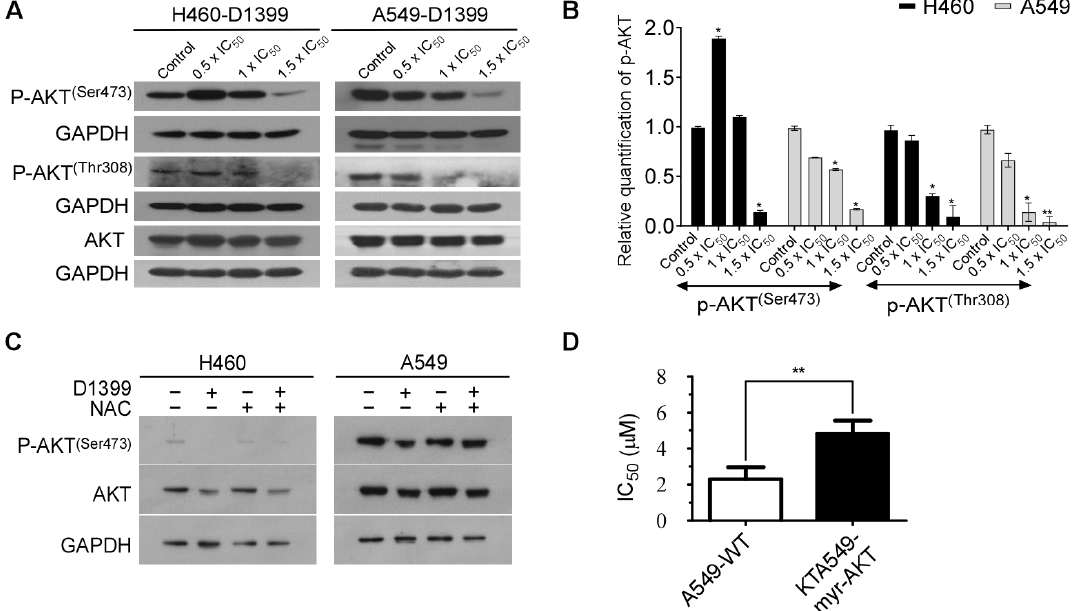
Figure 5. D1399 induces the ROS-dependent inactivation of the AKT signaling pathway in H460 and A549 cells. ( A ) The levels of AKT phosphorylation at Ser473 and Thr308 and total AKT were tested under the treatment of D1399 at indicated concentrations by western blotting in H460 and A549 cells. GAPDH is used as the control; ( B ) Bar graphs illustrating the relative expression levels of p-AKT proteins quantified by western blotting. All protein levels were normalized to the GAPDH protein level; ( C ) The levels of AKT phosphorylation at Ser473 and total AKT were tested by western blotting in H460 and A549 cells. The cells were either treated with D1399 for 6 h or pre-treated with 2 mM NAC for 1 h before D1399 treatment. GAPDH is used as the control; ( D ) The IC 50 of A549-WT and A549-myr-AKT under the treatment of D1399 are compared. Results are expressed as arbitrary units. Data for the quantitative assessment of the proteins are expressed as means ± SD. *, p < 0.05, **, p < 0.01.